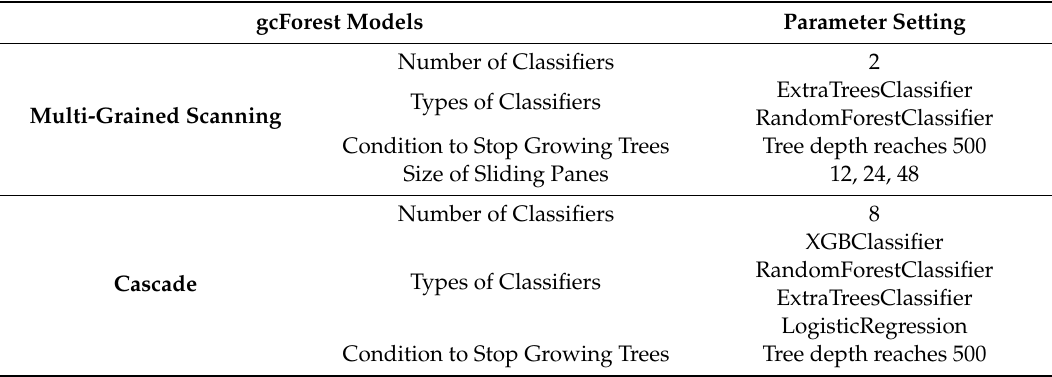
Table 5. Initial experimental parameter setting.